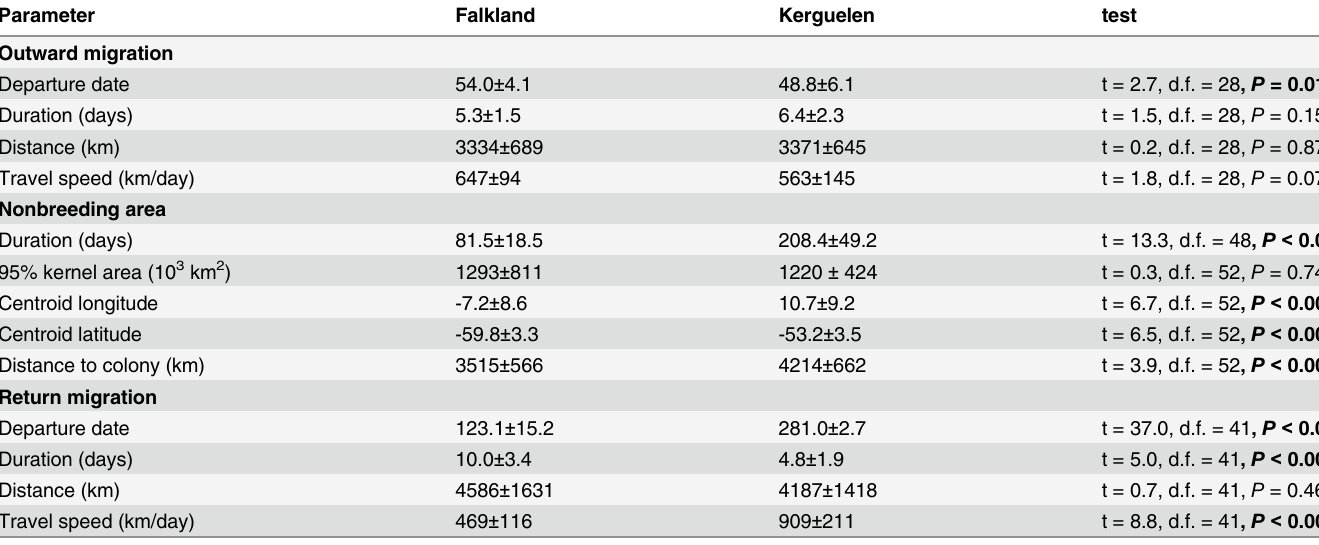
Table 2. Timing and duration of the migration and non-breeding areas in thin-billed prions from New Island, Falkland and Île Mayes, Kerguelen (means ±